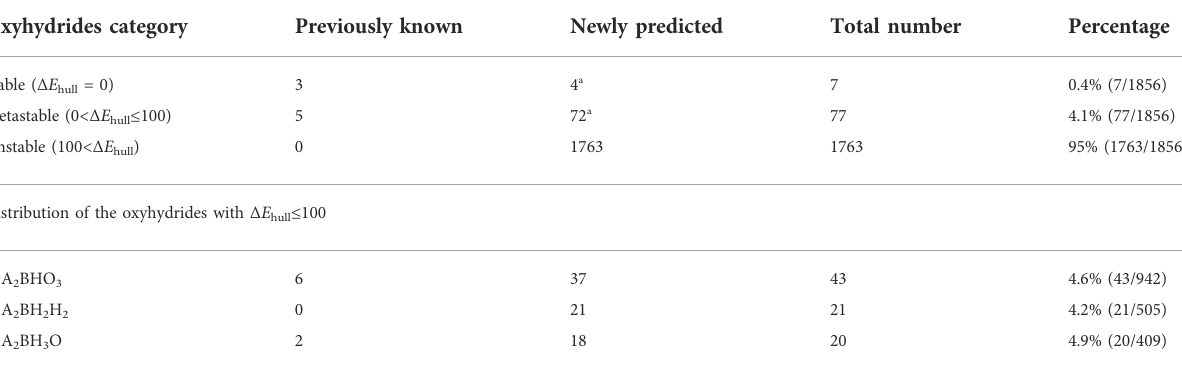
TABLE 1 Statistics of the known and newly predicted oxyhydrides in terms of Δ E hull and compositions. There are eight experimentally synthesized compounds,whichareLn 2 LiHO 3 (Ln=La,Pr,Nd,Sm)(Kobayashi etal.,2016;Iwasakietal.,2018),Ba 2 MHO 3 (M=Sc,Y)(Takeirietal.,2019;Nawaz et al., 2020) and M 2 LiH 3 O (M = Sr, Ba) (Kobayashi et al., 2016; Takeiri et al., 2022).